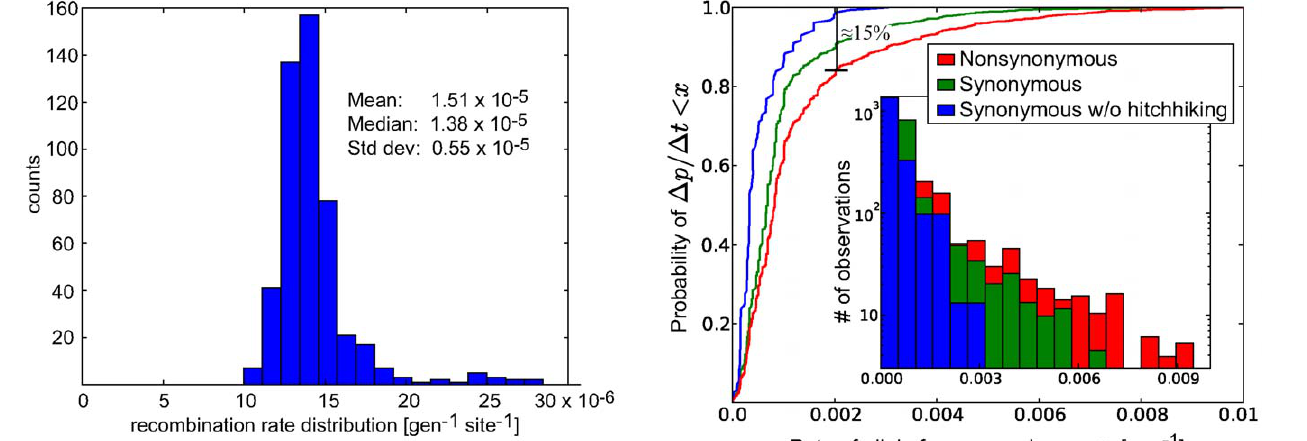
Figure 4. Selection on non-synonymous mutations. The figure shows cumulative distributions of the observed rate of change D p = D t of the allele frequencies p between two consecutive samples at times t i and t i z 1 for non-synonymous polymorphisms, synonymous polymor- phisms, and synonymous polymorphisms at least 100bp away from the nearest fast changing non-synonymous polymorphism ( w 0 : 002 /gener- ation), see methods. The inset shows the corresponding histograms on a logarithmic scale. Only pairs of time points with sample sizes greater than 10 sequences are included.